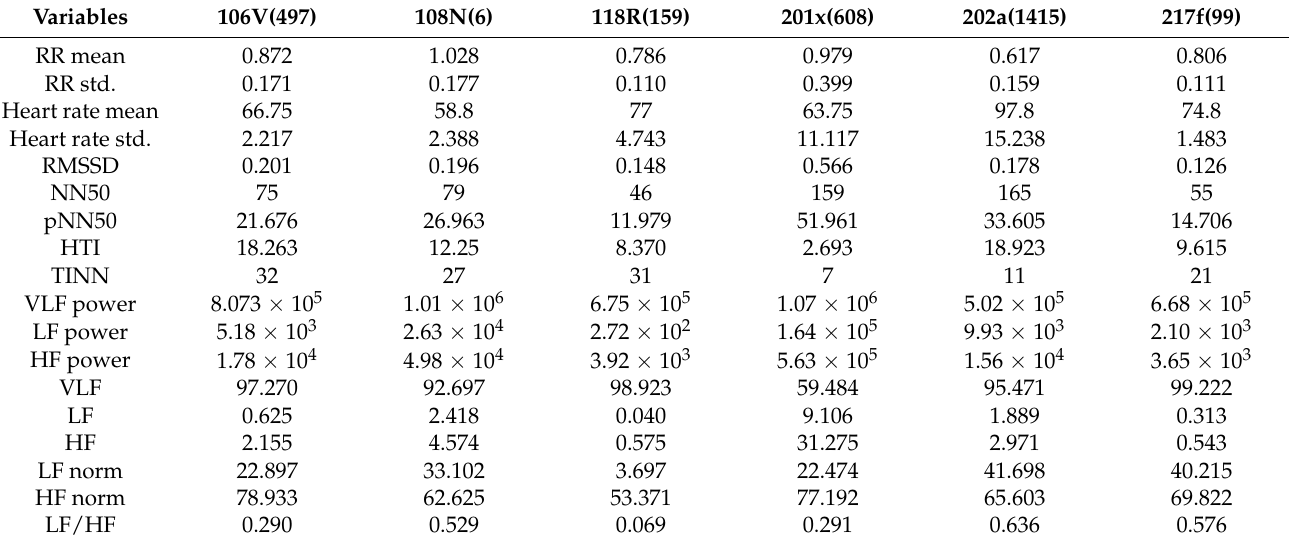
Table 7. HRV analysis for test records of